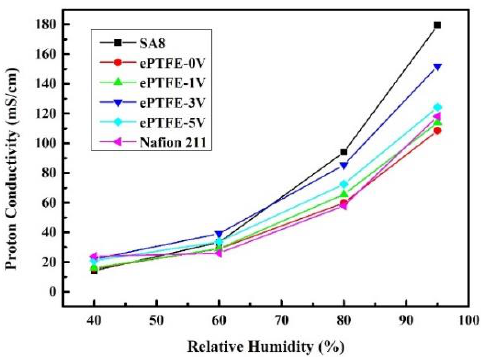
Figure 11. Proton conductivity of ePTFE membranes at 80 °C and various relative humidities.